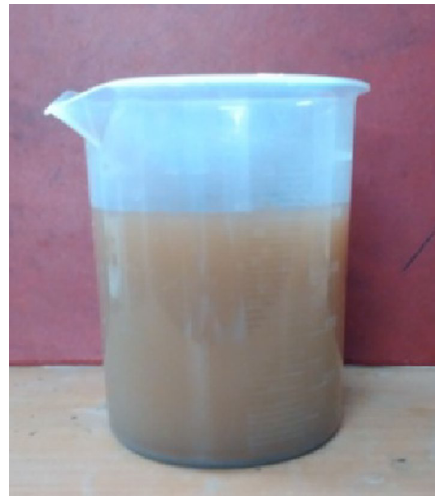
Fig. 2 Soil sample mixed with water